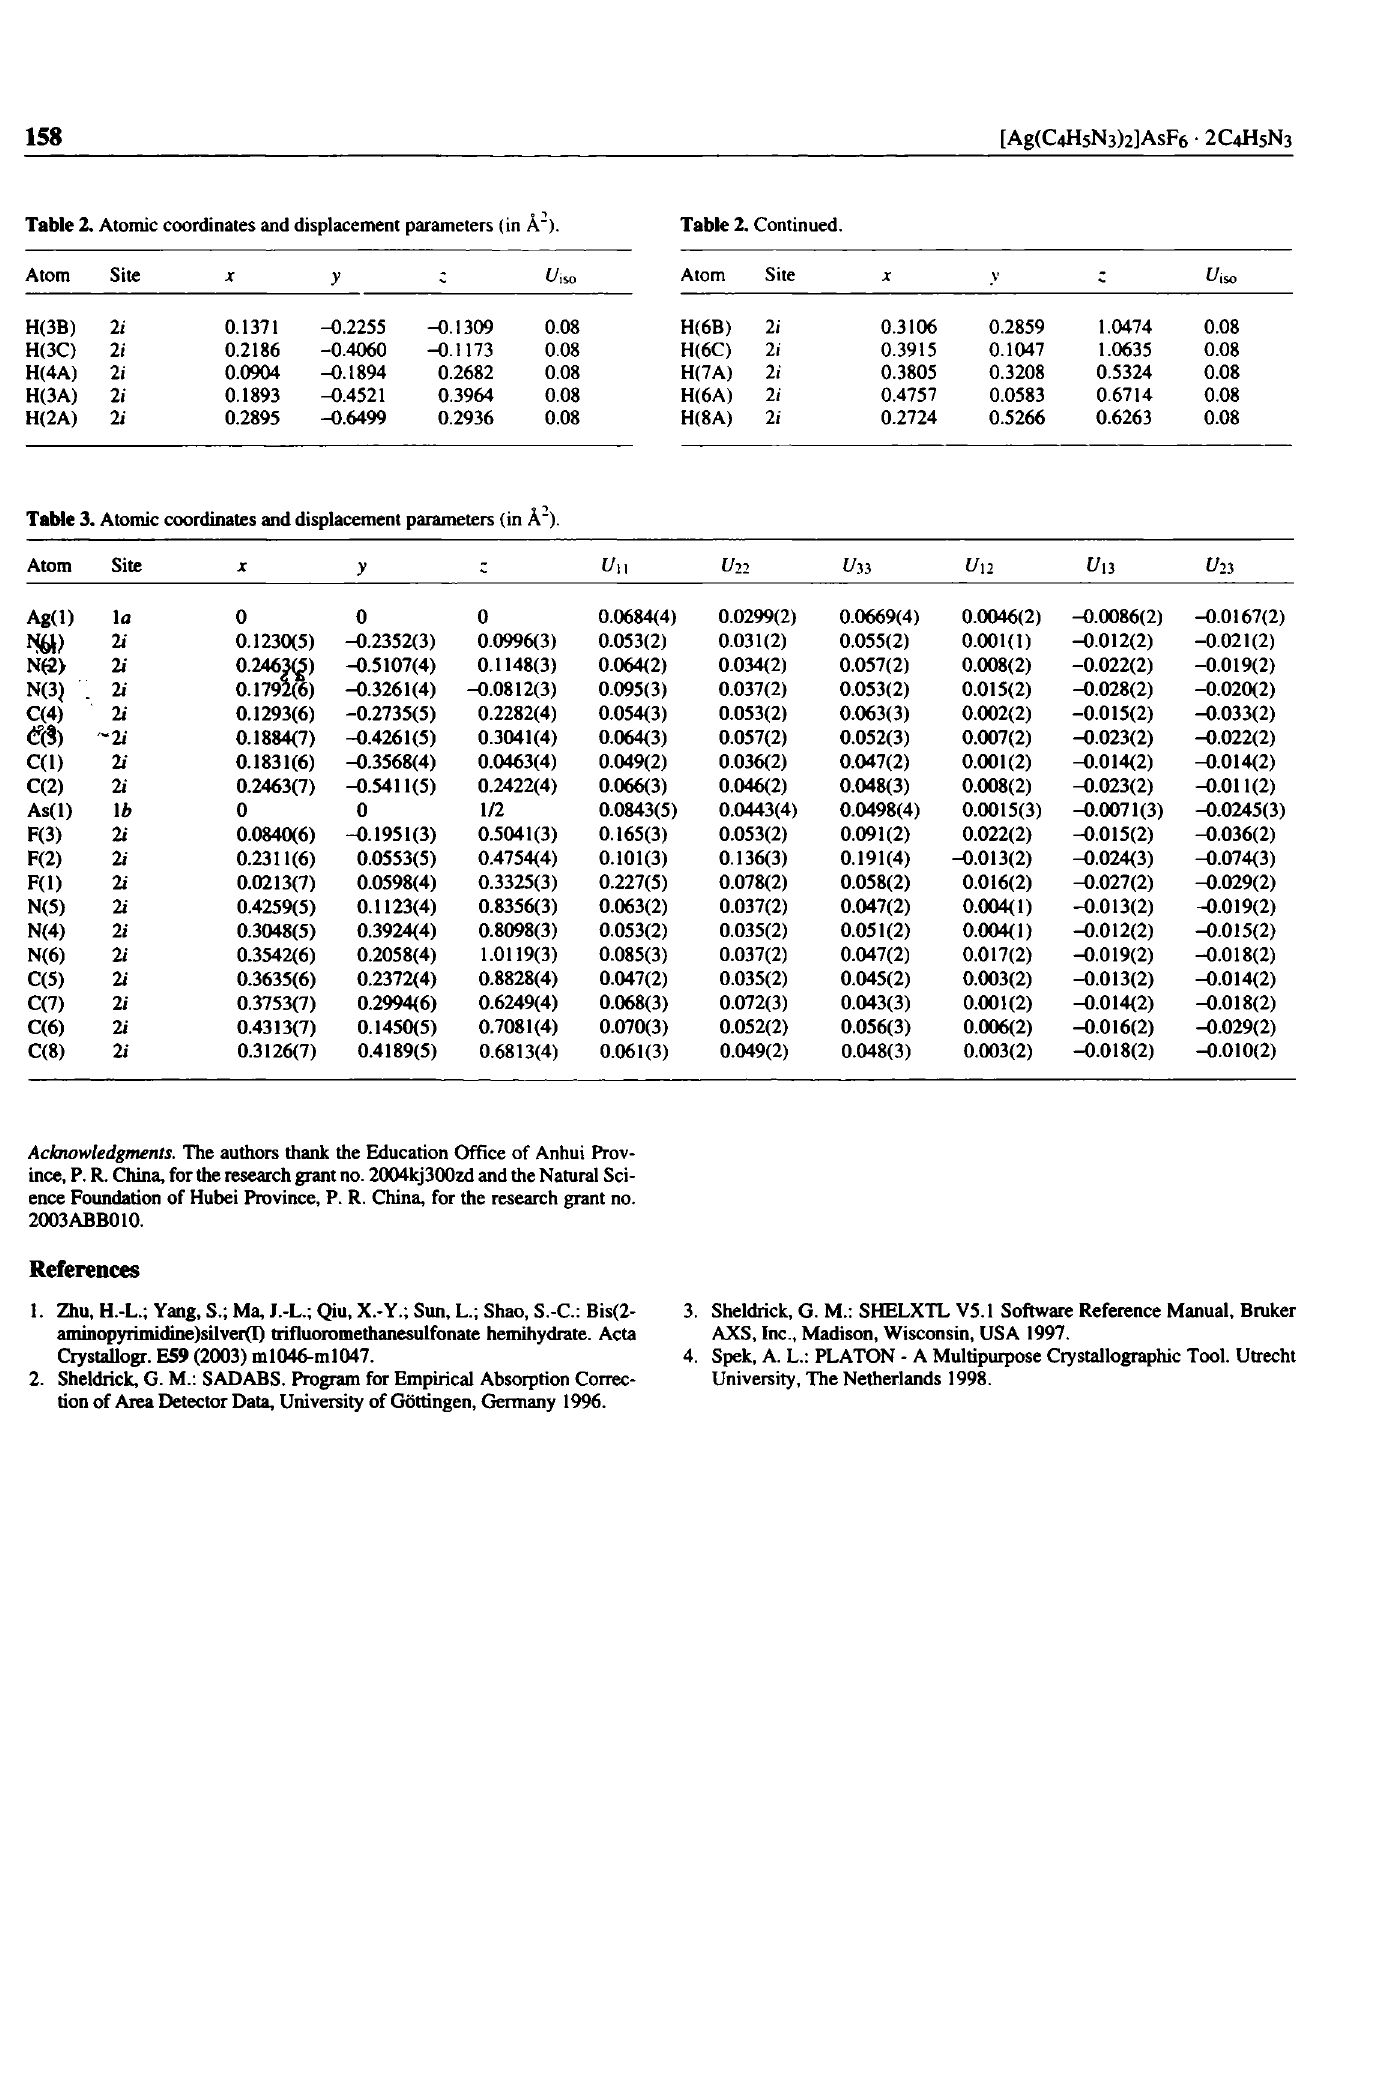
Table 2. Atomic coordinates and displacement parameters (in A"). Atom Site